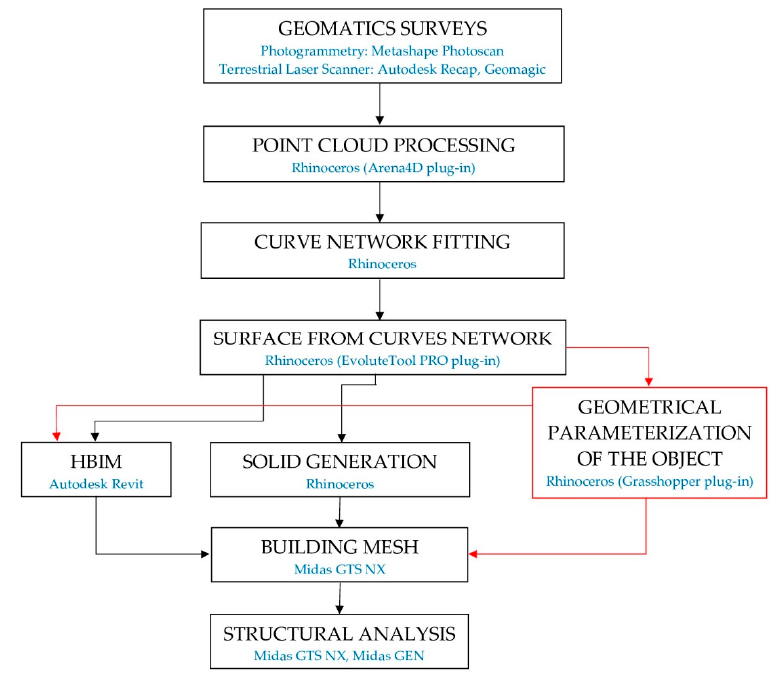
Figure 1. Pipeline of the developed method.